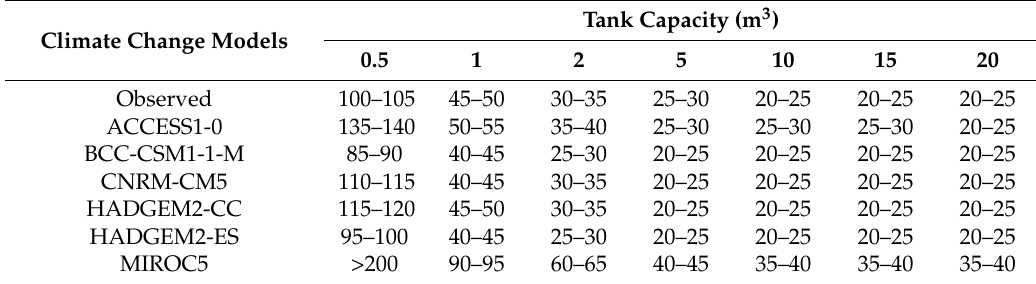
Figure 27. Change in reliability for MAM 2060–2090 period for 5 m 3 tank size. As shown in Figures 29 and 30, when tank size increases to 2 and 5 m 3 , 80% reliability is achieved at very small roof sizes of 35 m 2 or even smaller under observed scenario. ACCESS1-0, BCC-CSM-1- M, and CNRM-CM5 models closely follow the observed scenario and hence show the same reliability. For HADGEM2-CC, HADGEM2-ES and MIROC5 predictions, due to lower reliability predictions, 80% reliability can only be achieved at 80 and 60 m 2 for tank sizes of 2 and 5 m 3 respectively. Figures 29–31 also show that with larger roof sizes and increased tank capacity, model predictions converge. Increasing tank volume to 10 m 3 or more (as shown in Figure 31) does not significantly decrease the roof size requirement for 80% reliability for all models. In fact, the graphs show that for smaller roof sizes (up to 70 m 2 ), model predictions are widely different regardless of tank size. It is thus more beneficial to increase roof size than tank size during this period.